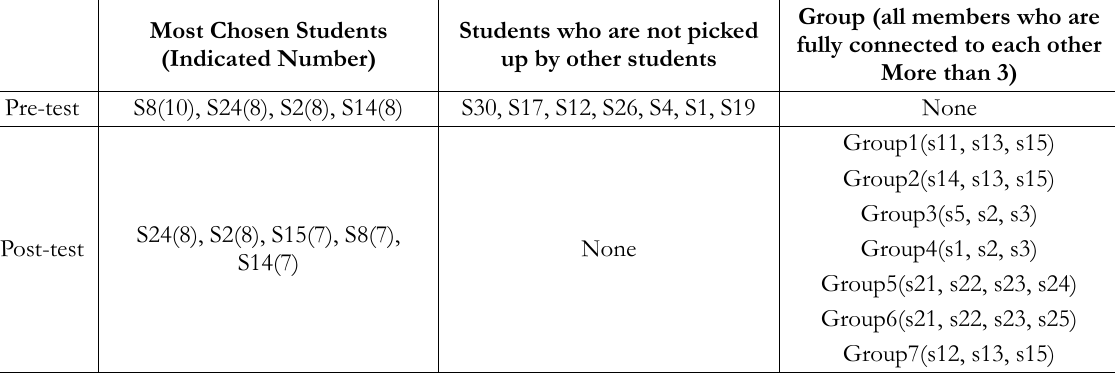
Table 9. Friendship Before and After Science Class Applying STAD Cooperative Learning